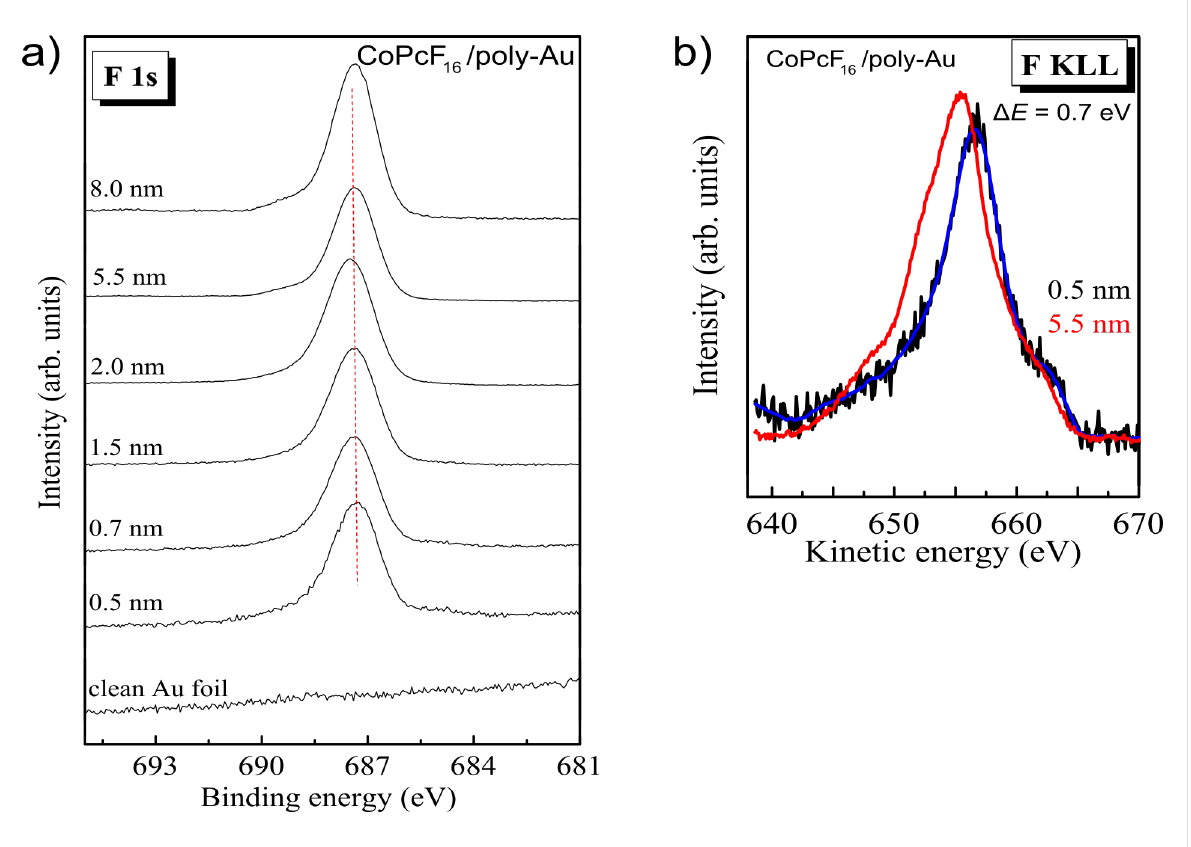
Figure 2: CoPcF 16 on polycrystalline (poly-) Au: (a) F 1s core level spectra and (b) F KLL Auger spectra during the interface